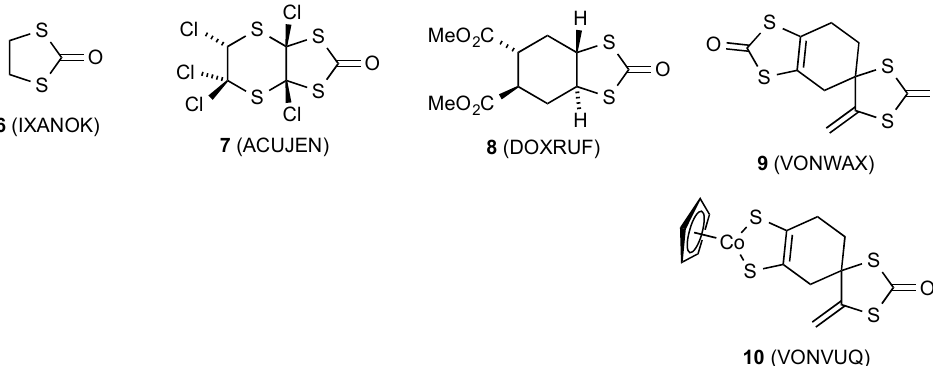
Figure 3. A survey of crystallographically characterised 1,3-dithiolan-2-ones with Cambridge Structural Database (CSD) reference codes. Table 2. Key angles in the structures of dithiolanones (°).